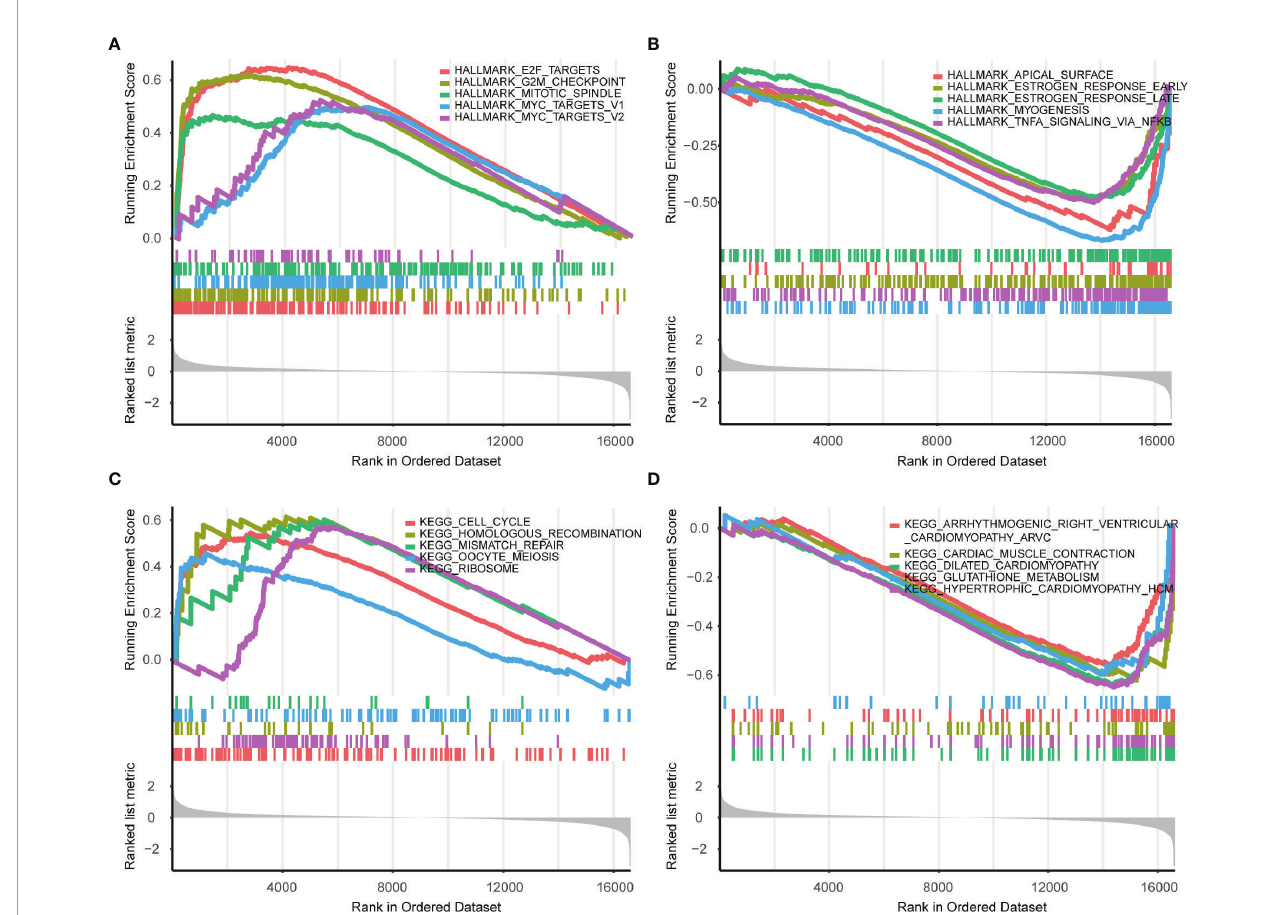
FIGURE 5 | GSEA enrichment analysis in Hallmarks and KEGG (S2 vs S1). (A) The top fi ve upregulated hallmarks. (B) The top fi ve downregulated hallmarks. (C) The top fi ve upregulated pathways in KEGG. (D) The top fi ve downregulated pathways in